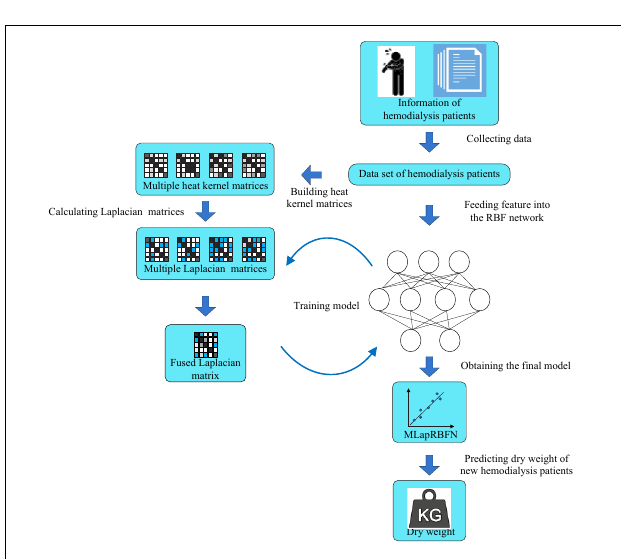
FIGURE 2 | Flow chart of multiple Laplacian-regularized RBF network (MLapRBFN).